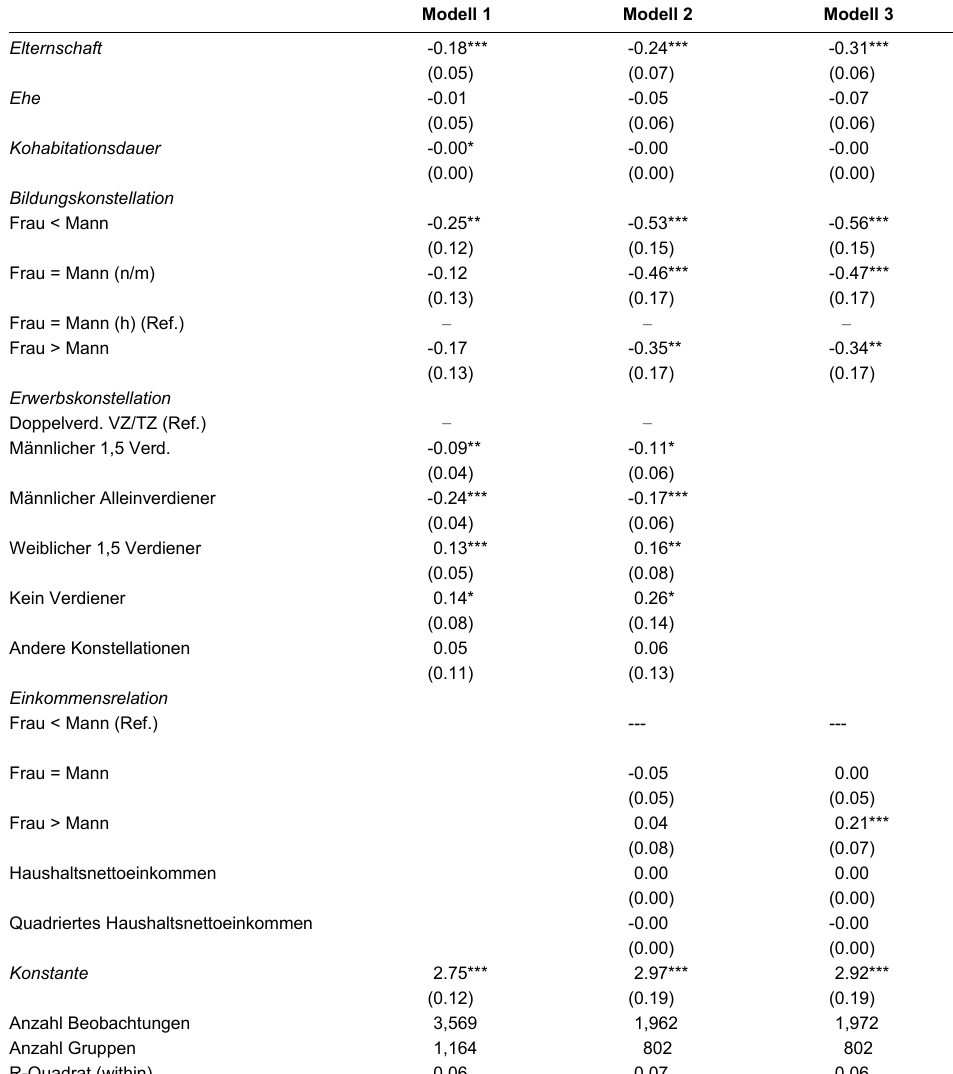
Tabelle 3 : Multivariate Analyse der Einflussfaktoren auf die Hausarbeitsteilung im Längsschnitt Modell